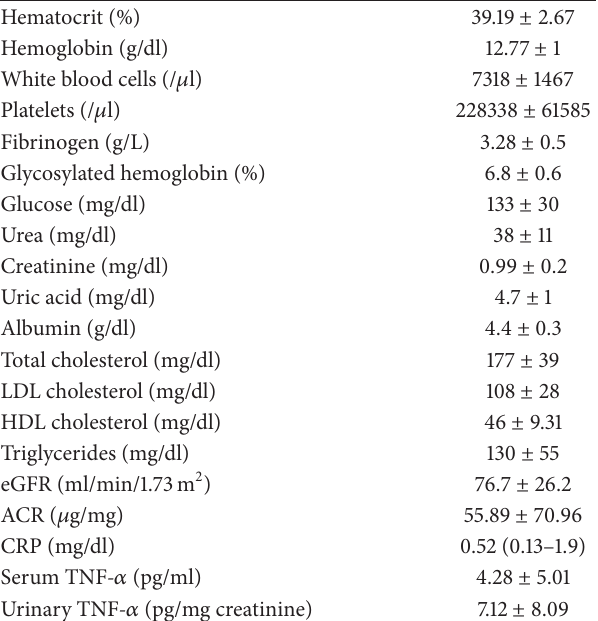
Table 2: Laboratory findings of 80 patients with diabetes